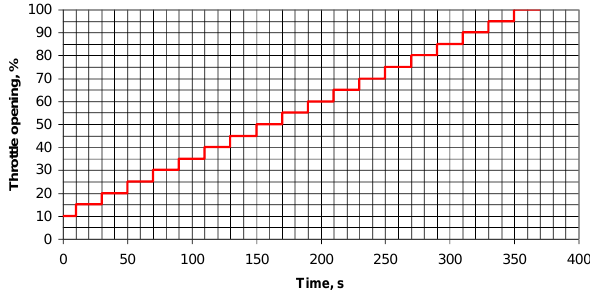
Fig. 5. The method of gradual throttle opening during the test